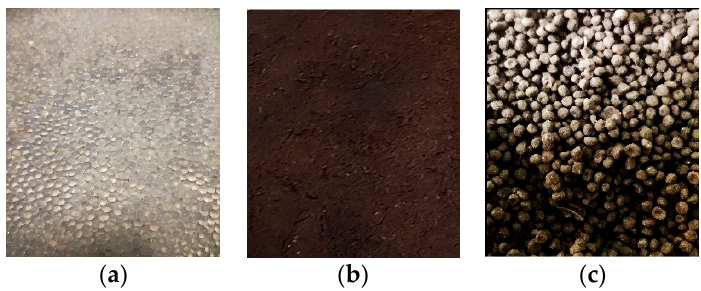
Figure 1. ( a ) Alginate beads; ( b ) Hydrothermal carbon (HTC) from corn stalks; ( c ) Alginate/HTC